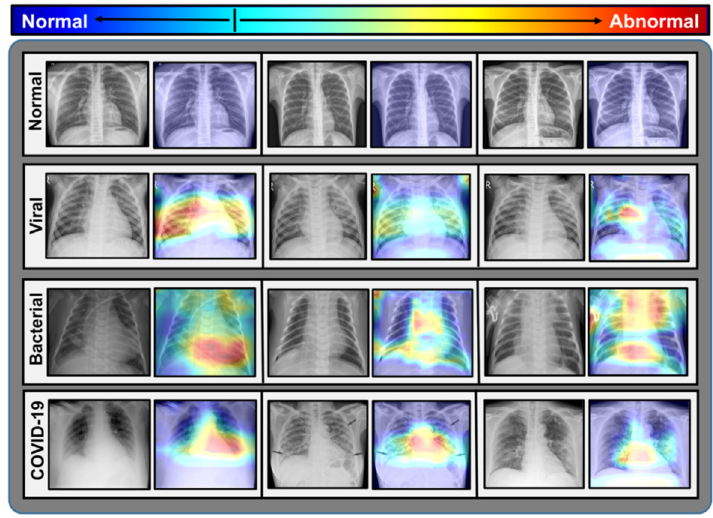
Figure 11. COVID-19 cases detection